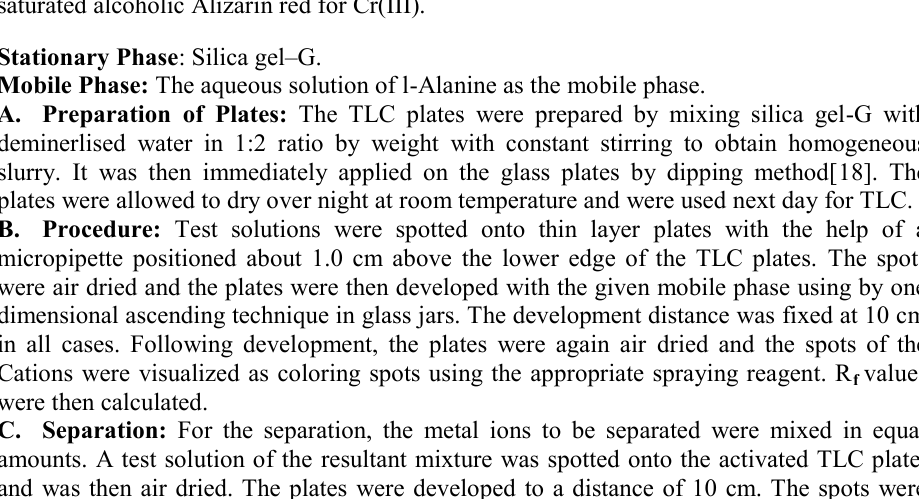
Table 1. Effect of Concentration on the R